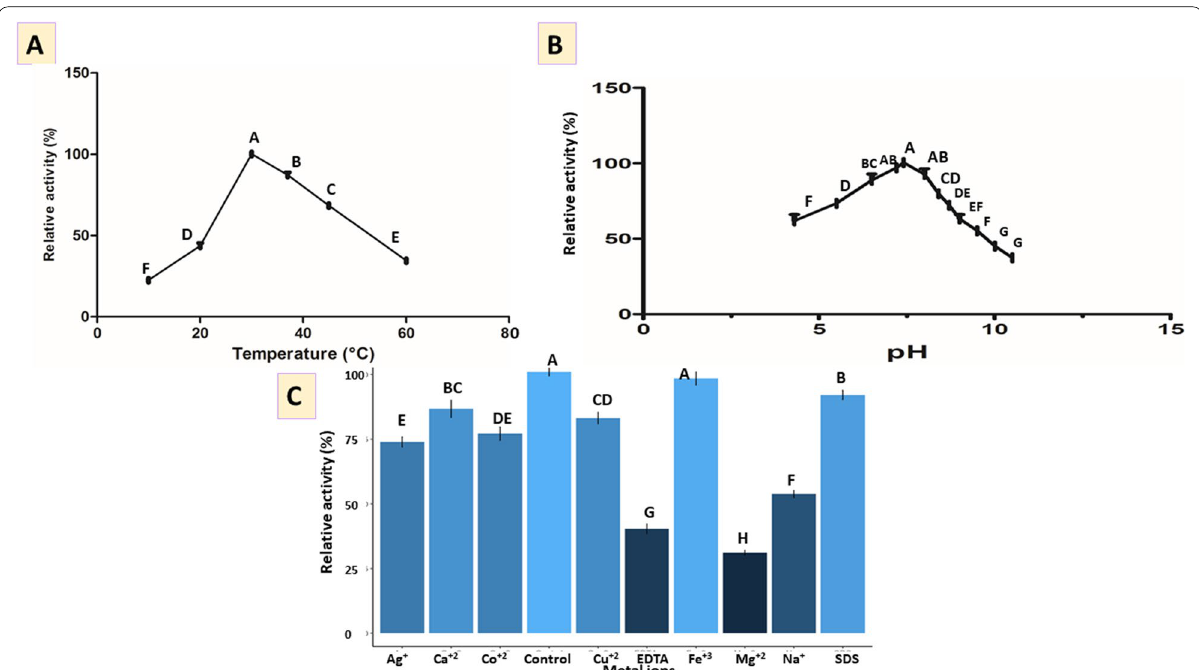
Fig. 3 Effect of different physicochemical parameters on cel9z cellulase activity. A Temperature, B pH, C Metal ions and some chemical reagents. *Columns with different letters are significantly different from each other using Tukey’s post hoc test P value ˂